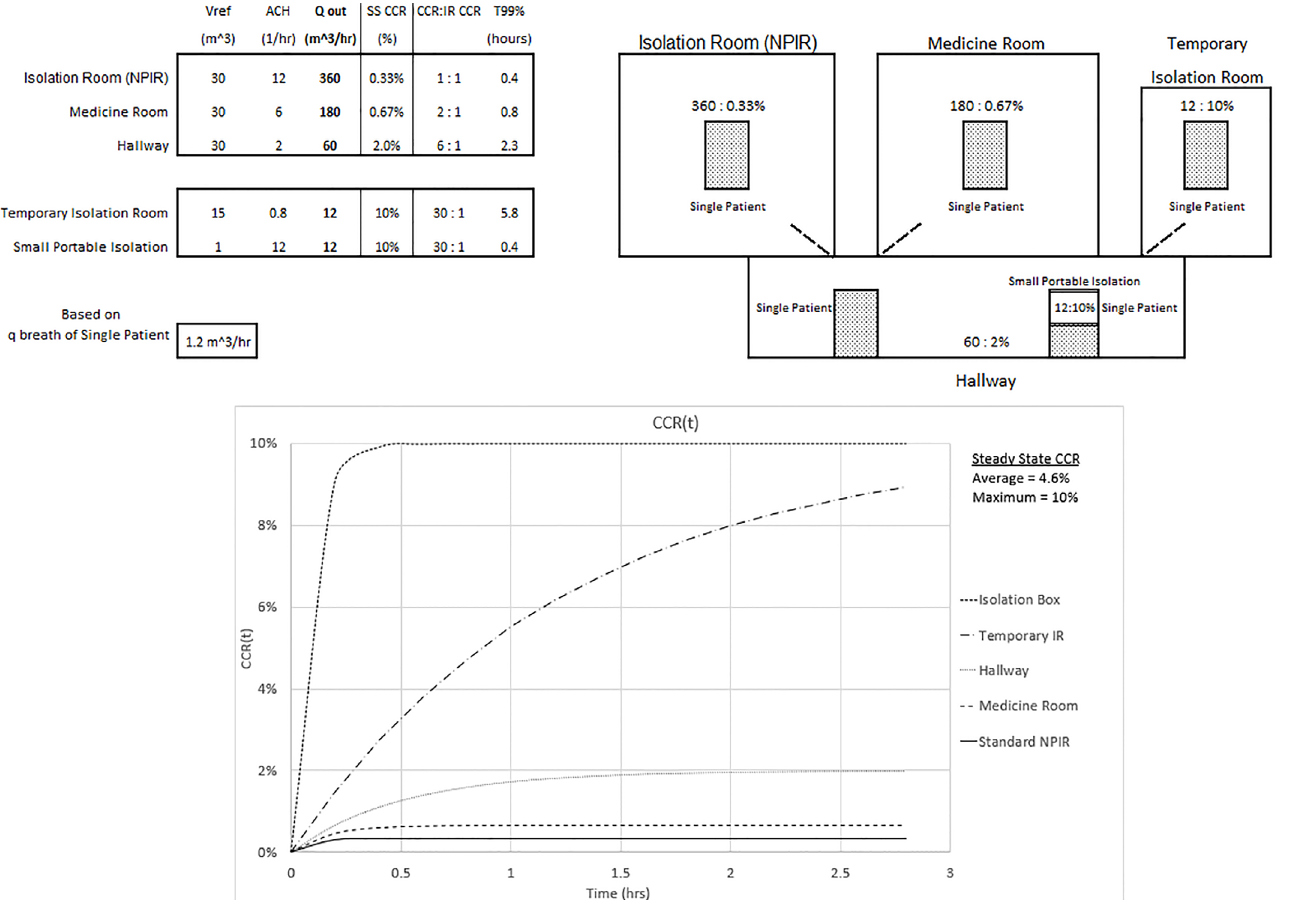
Figure 3. Configuration and CCR(t) of steady state average and maximum CCR exposures of 4.6% and 10% for equal time with all patients (average is 14 times the exposure of a standard isolation room CCR of 0.33%). NPIR, negative pressure isolation room; SS, steady state; CCR, contaminant concentration